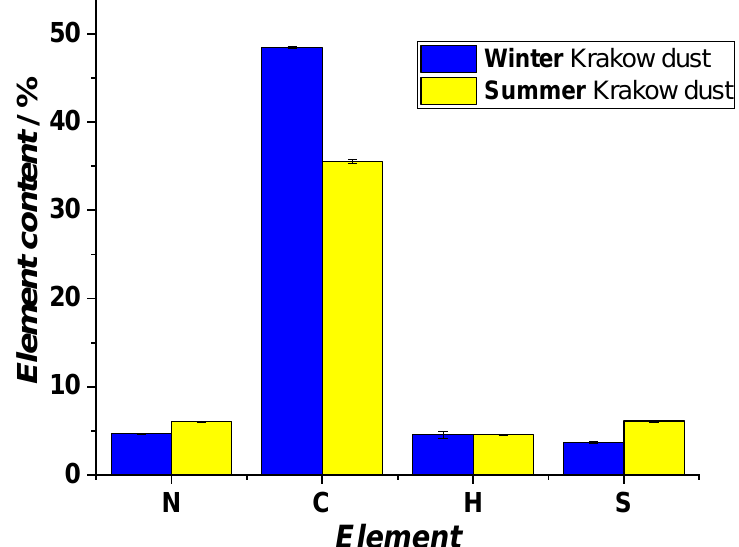
Figure 1. Comparison of the C, H, N, and S elemental content in Krakow winter and summer dust collected in 2019/2020.